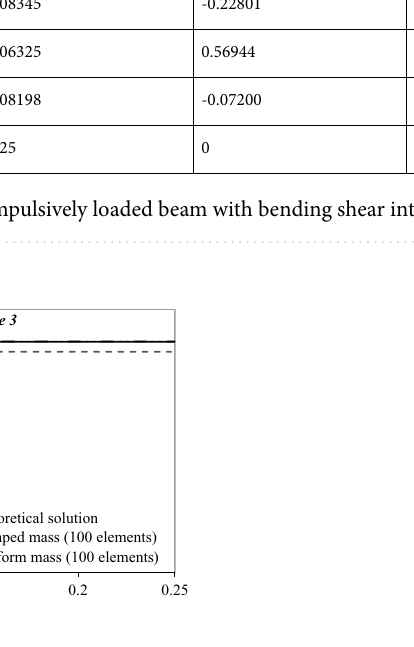
Figure 18. Comparison of transverse shear deformation evolving during the first phase of motion and staying constant in the later phases.